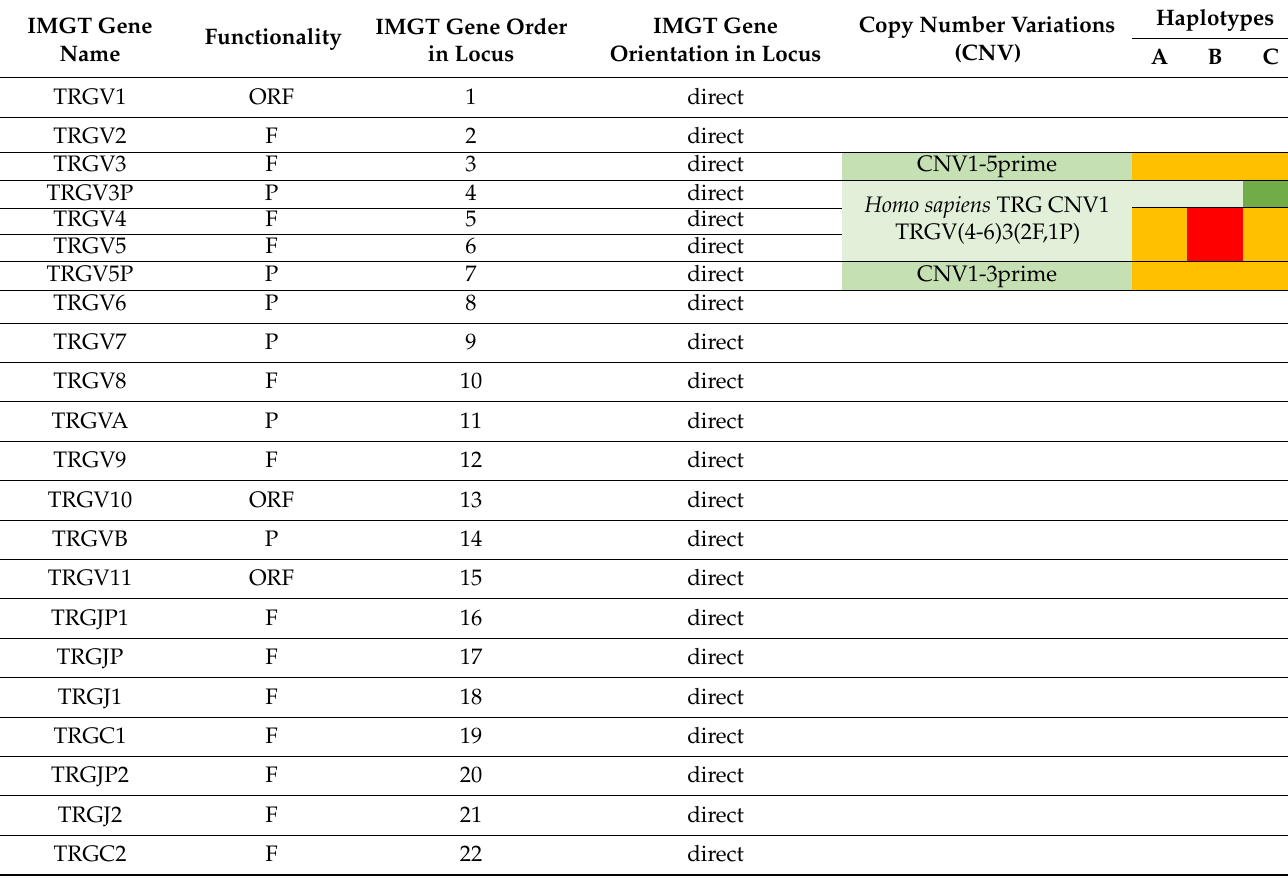
Table 9. Homo sapiens TRG locus: IMGT gene order, copy number variations (CNV) and